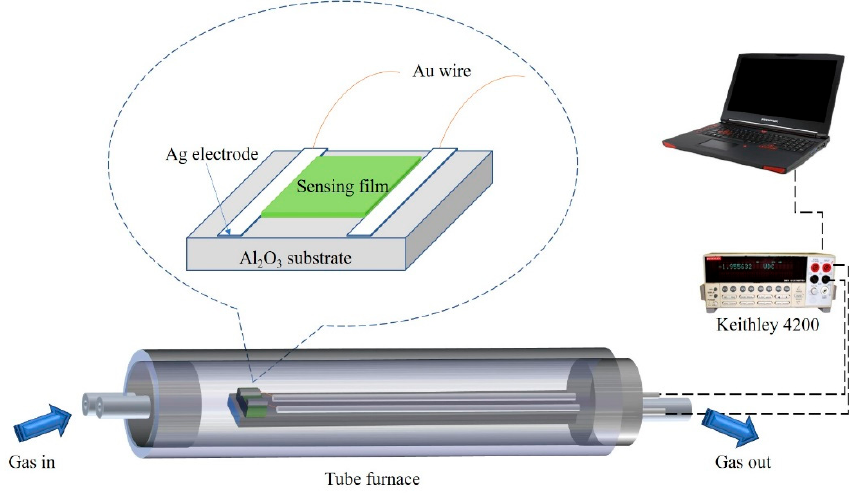
Figure 2. Illustration of gas sensor structure and test device.